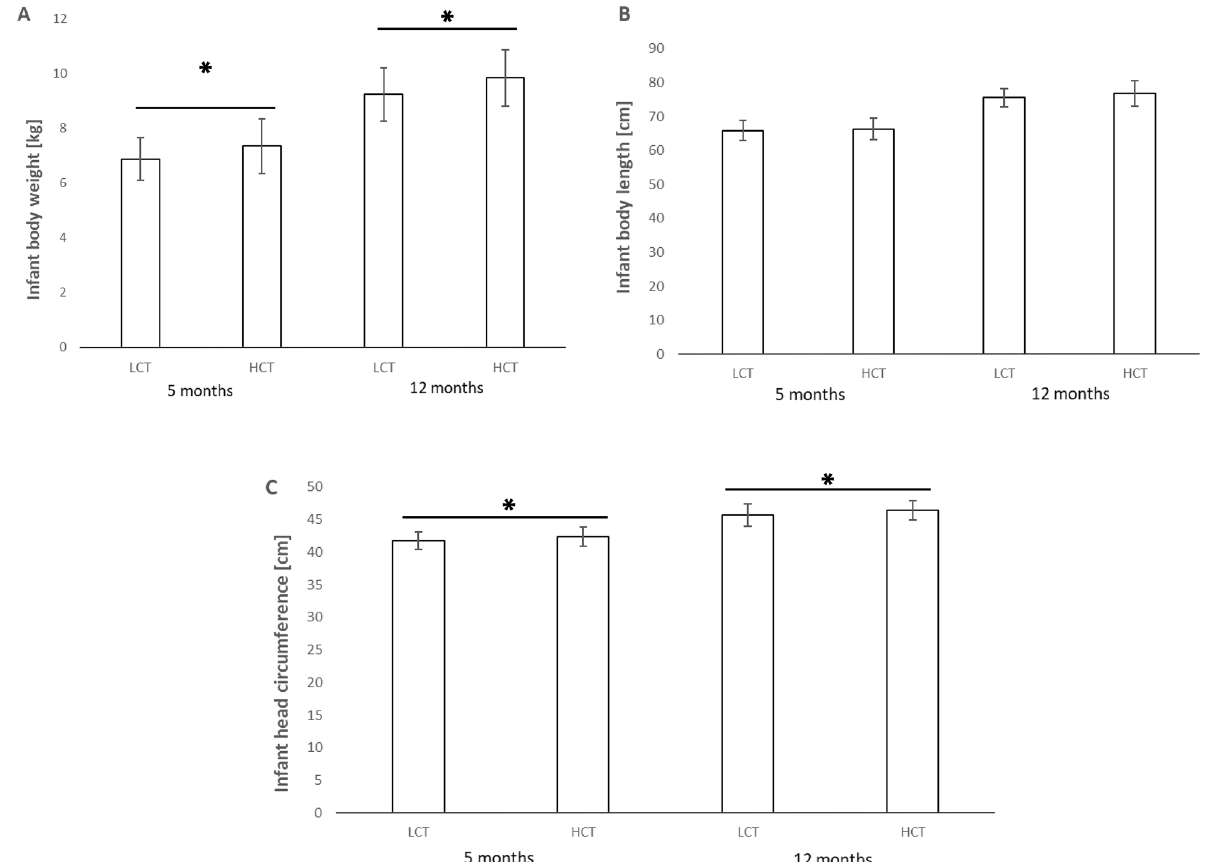
Figure 1. Mean and standard deviations for infant body weight ( A ), length ( B ) and head circumference ( C ) in LCT and HCT mothers at the age of 5, and 12 months. Significant differences